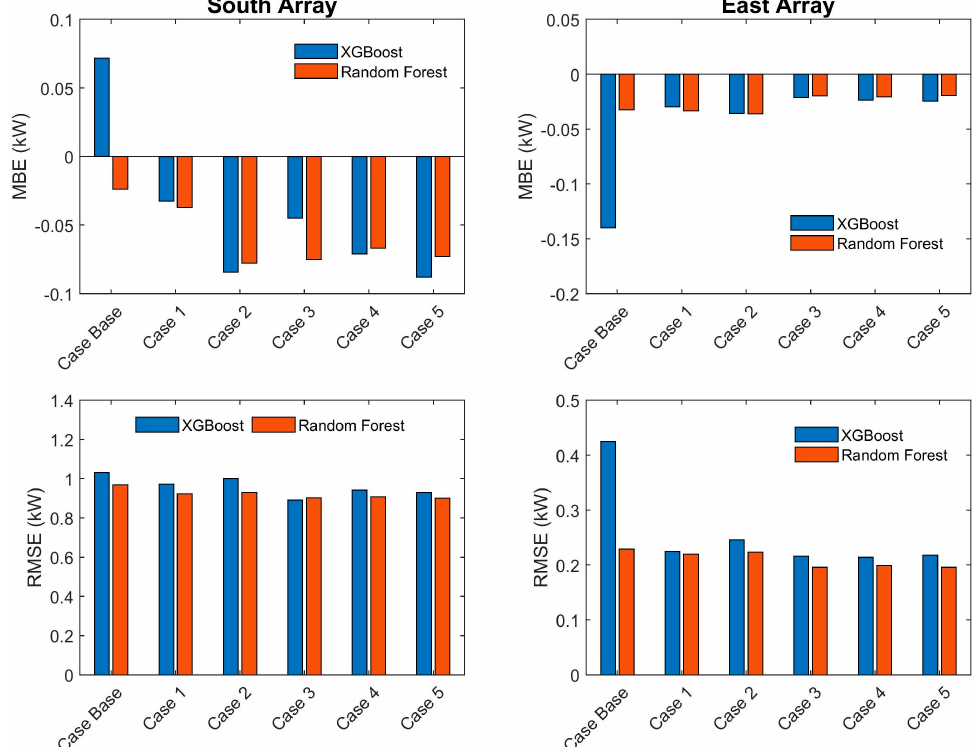
Figure 6. MBE and RMSE values for both arrays and all the cases.